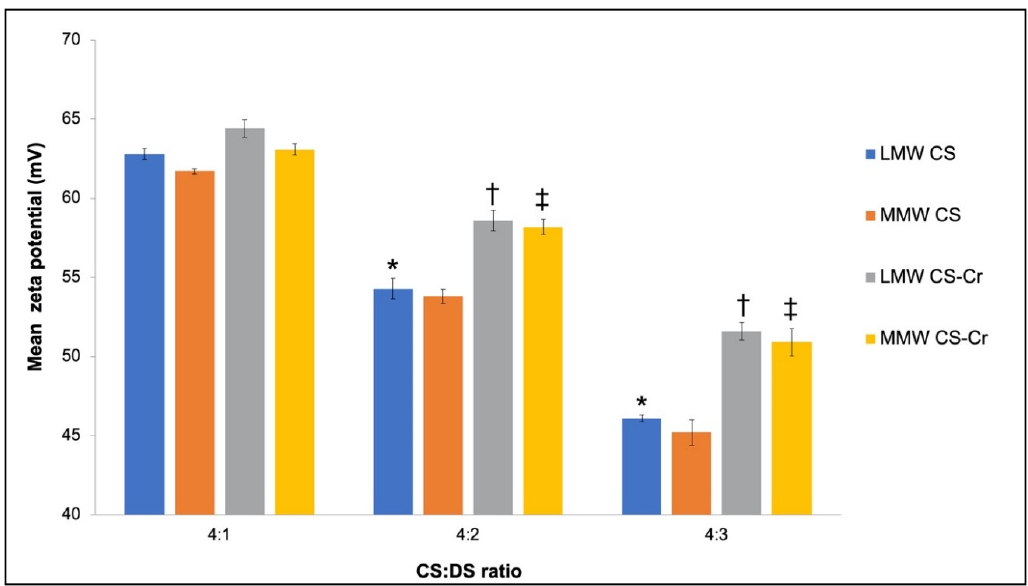
Figure 3. Zeta potential of chromium-entrapped CS-DS nanoparticles when using different MWs of chitosan at various CS:DS ratios. Results are shown as mean ± SD (n = 3). Data were considered statistically different when p < 0.05. * indicates significant difference comparing 4:1 LMW CS to LMW CS samples at other ratios, † indicates a significant difference between LMW CS and LMW CS-Cr at the same ratio, ‡ indicates a significant difference between MMW CS and MMW CS-Cr at the same ratio.